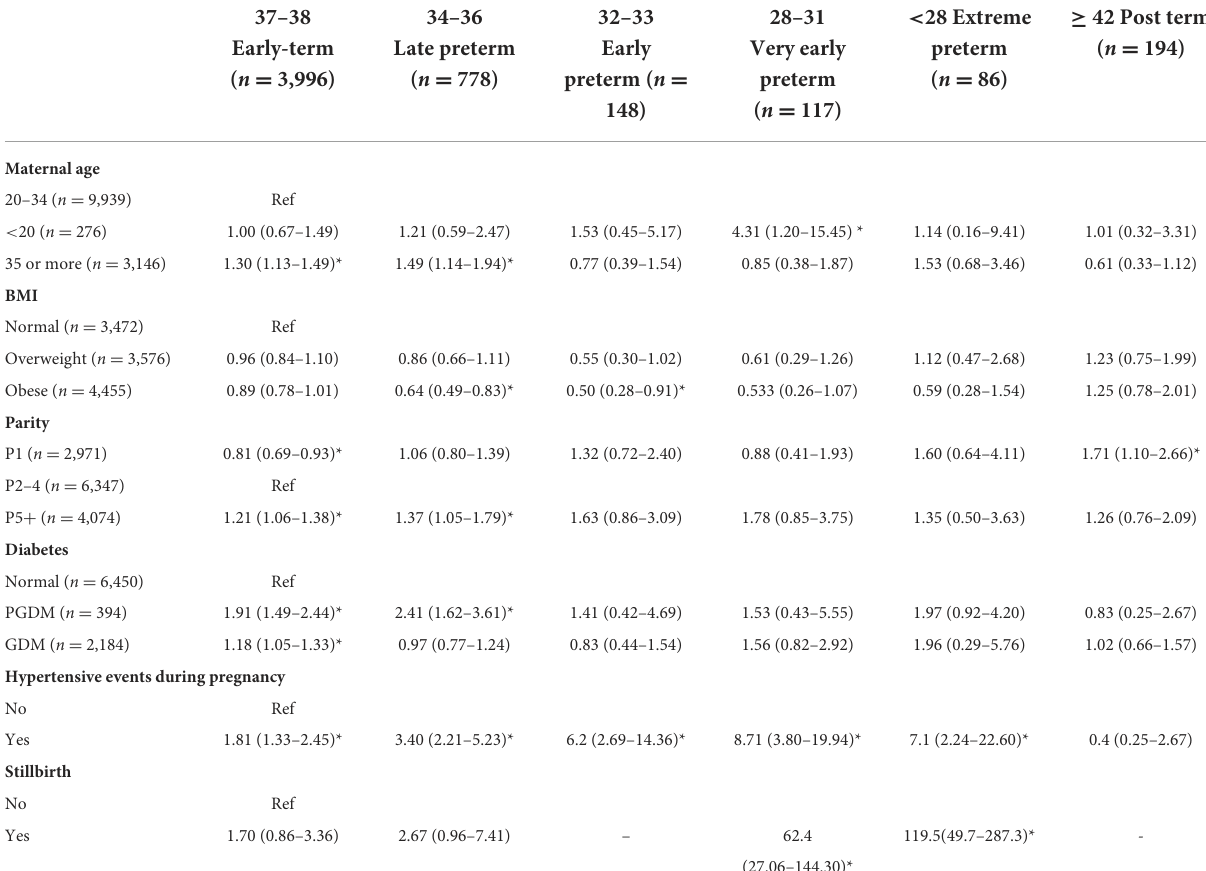
TABLE 2 Independent effect of maternal and fetal factors on gestational age at delivery.